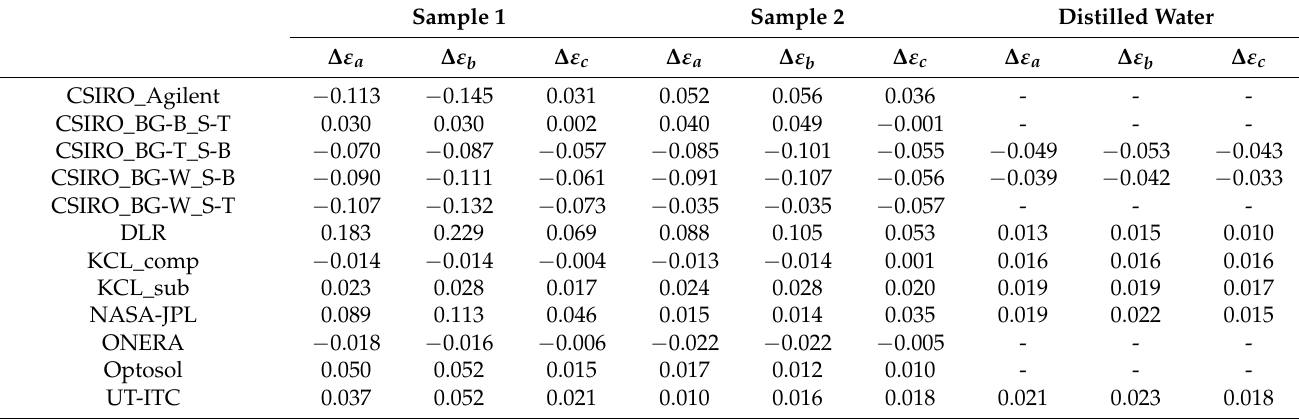
Figure 5. SE measurements of distilled water collected at a 4 cm − 1 spectral resolution over the 2.5–14 µ m wavelength range. Additionally, shown is the distilled water SE spectrum from the ECOSTRESS Spectral Library (ESL) [25]. The absorption bands of relevant gases (H 2 O and CO 2 ) are indicated through the grey vertical bars. As before, for legend abbreviations see Table 2. Table 4. The mean SE differences for each setup over specified wavelength ranges, calculated as ( ε – ε mean ) , where the mean emissivity ε mean was calculated using all spectra. As before, the subscripts a, b and c refer to the wavelength ranges averaged over, where a = 2.5–14 µ m, b = 3–5 µ m (MWIR region) and c = 8–14 µ m (LWIR